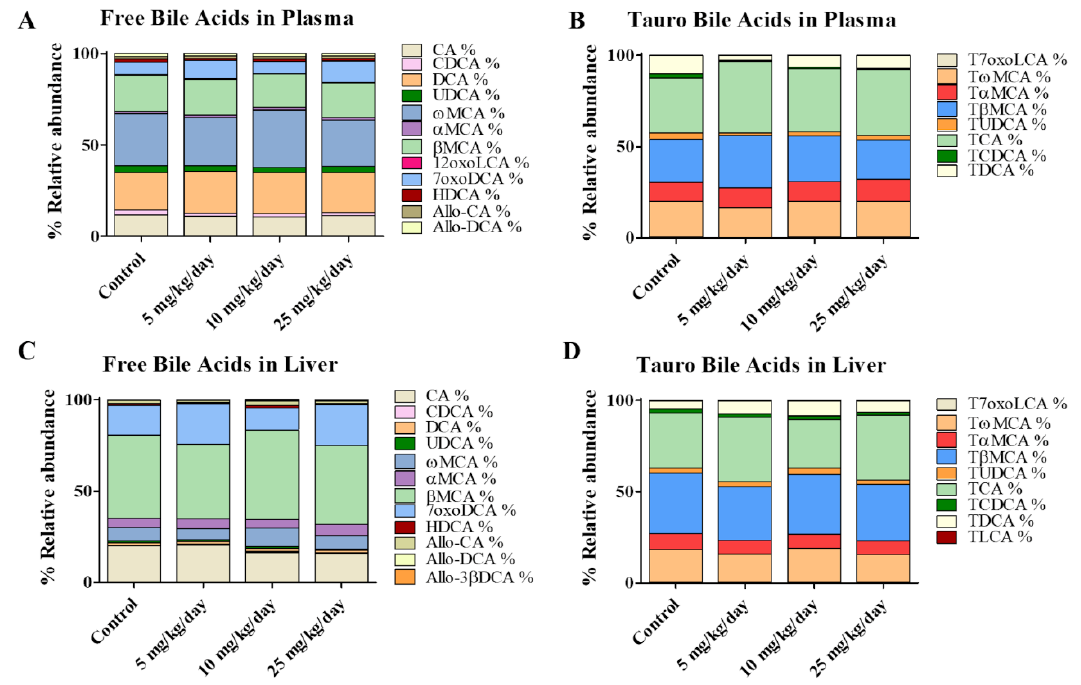
Figure 3. Bile acid composition analyzed in mouse plasma and liver tissue samples. Data represent relative abundances (%). The four groups correspond to control, and simvastatin exposure in mice at three different doses: 5, 10, and 25 mg/kg/day. ( A,C ) Profiles of free bile acids in plasma and liver tissue, respectively; ( B,D ) Taurine-conjugated bile acids in plasma and liver, respectively. n = 6 per group.